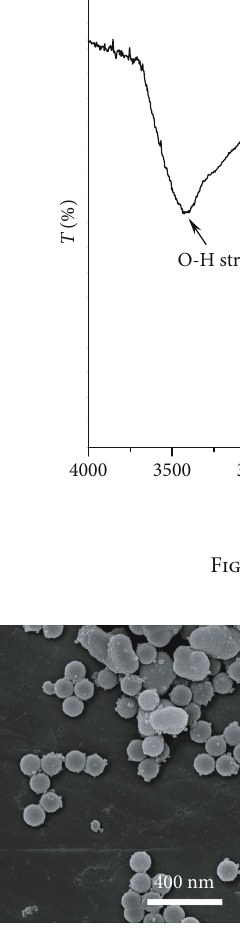
Figure 2: SEM image of